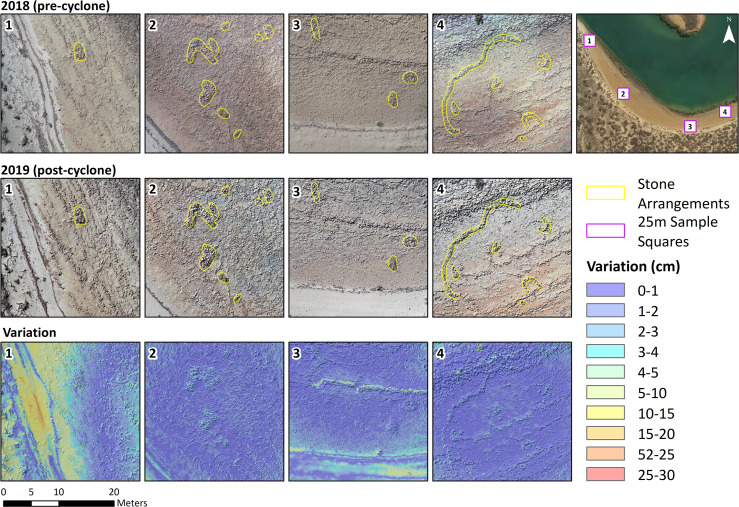
Comparison of the Cape Bruguieres Channel southern beachrock terrace from aerial survey before and after Cyclone Veronica.Area 1 shows the addition of sand in the dune behind the beachrock and a slight change in sediment depth on the platform. Area 3 shows only a slight change in the sediment at the edge of the dune and removal of a line of seaweed in the centre of the image. (Figure: E. Beckett and J. Benjamin). Overview aerial image (top right) reproduced by permission of the Western Australian Land Information Authority.